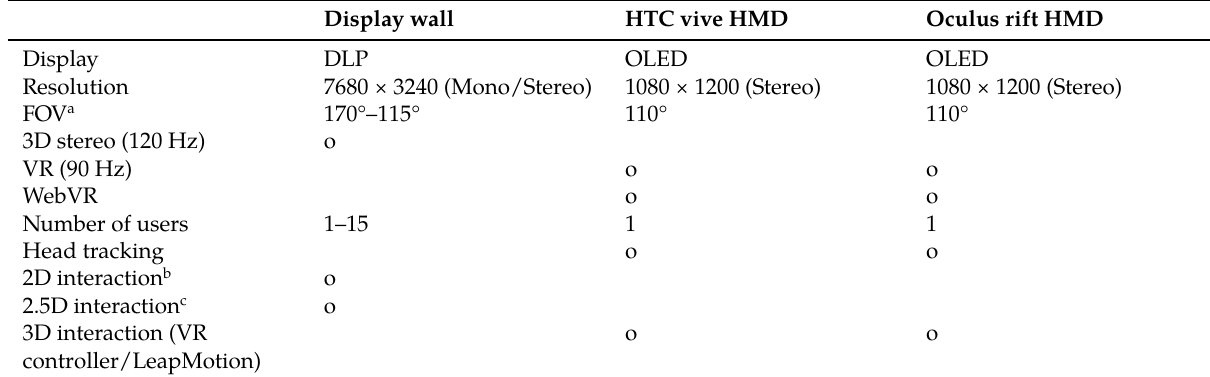
Table 1: Characteristics of the stereoscopic display hardware